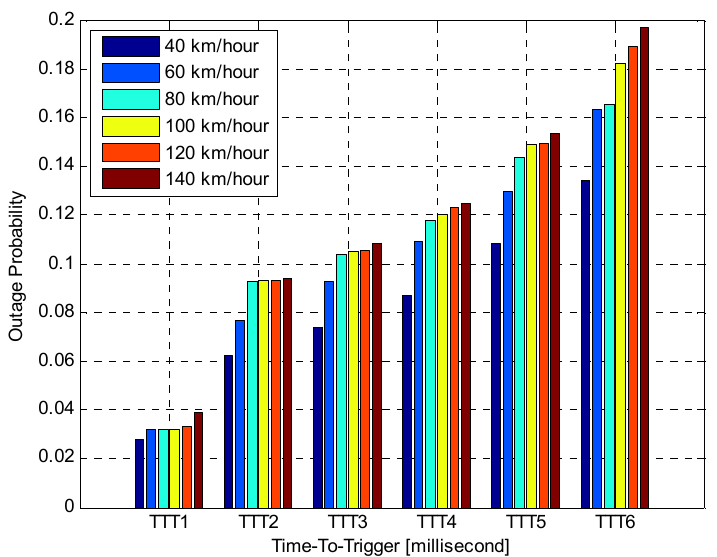
Figure 9. UE outage probability versus TTT interval.